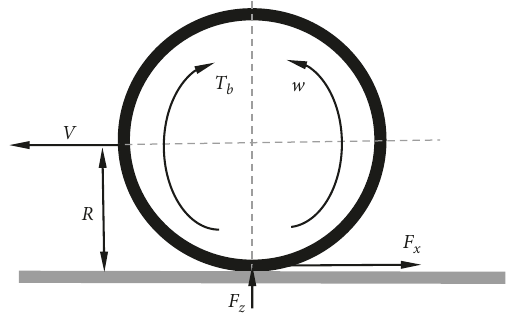
Figure 2: Single-wheel braking